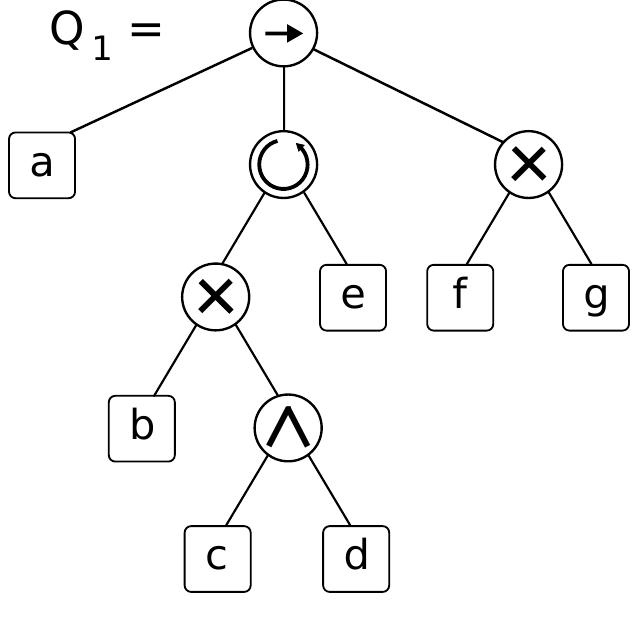
Figure 3. Example of a process tree